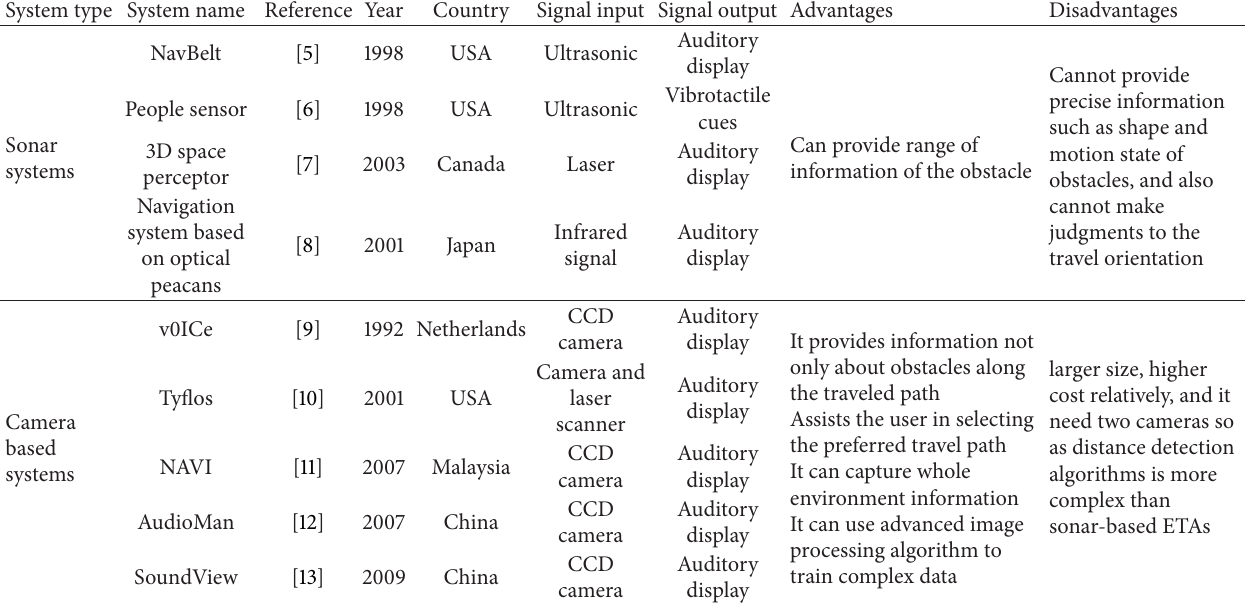
Table 1: Existing wearable blind guidance systems.